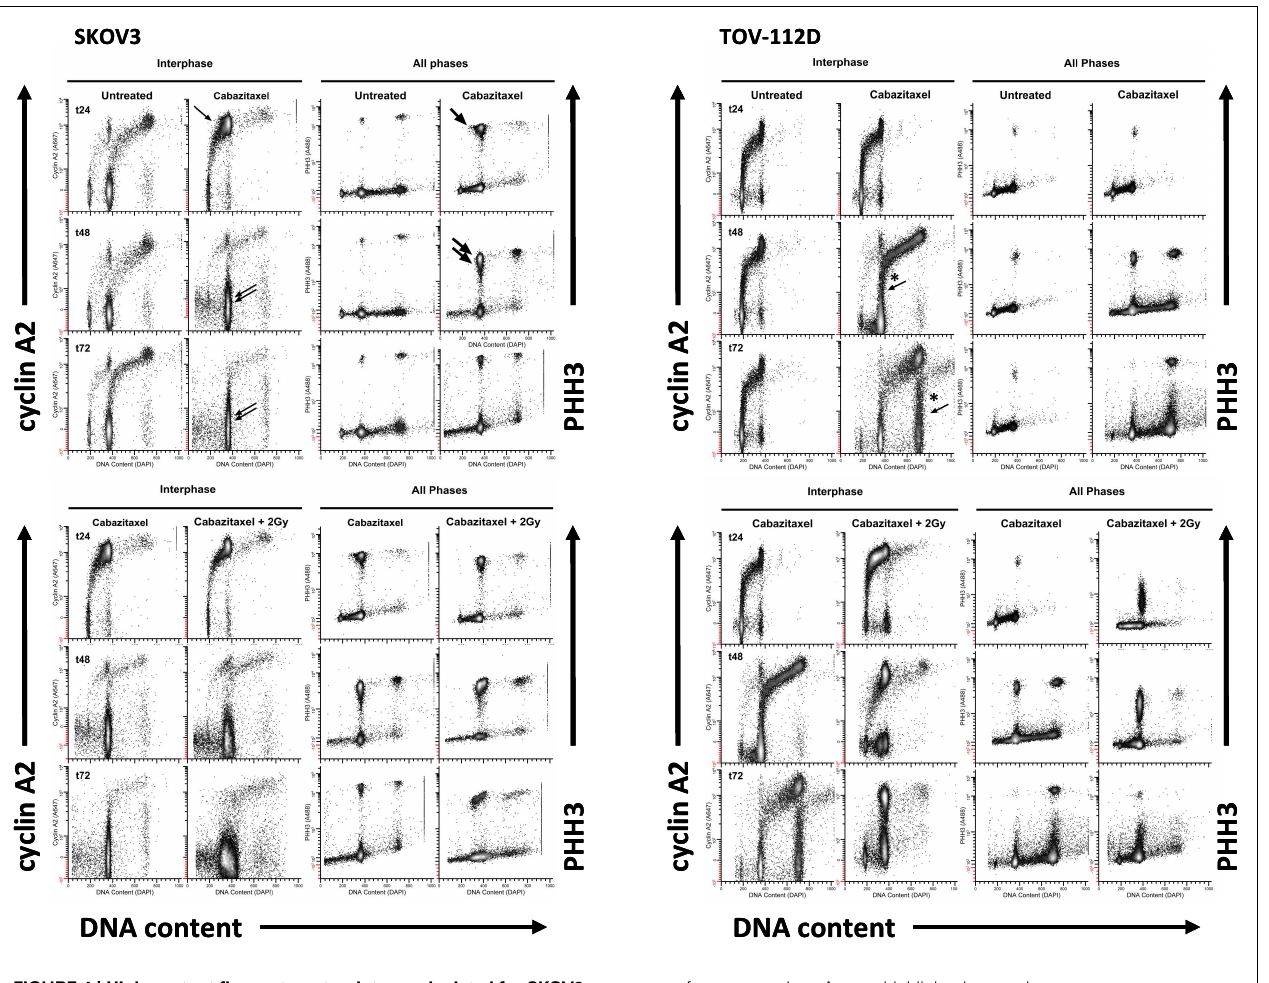
FIGURE 4 | High-content flow cytometry data are depicted for SKOV3 andTOV-112D cells . A 6-h cabazitaxel (1 µ M) exposure was studied; drug-free medium was exchanged at the 6-h time point. 24h (t24), 48h (t48), and 72h (t72) after initial cabazitaxel treatment is indicated for each